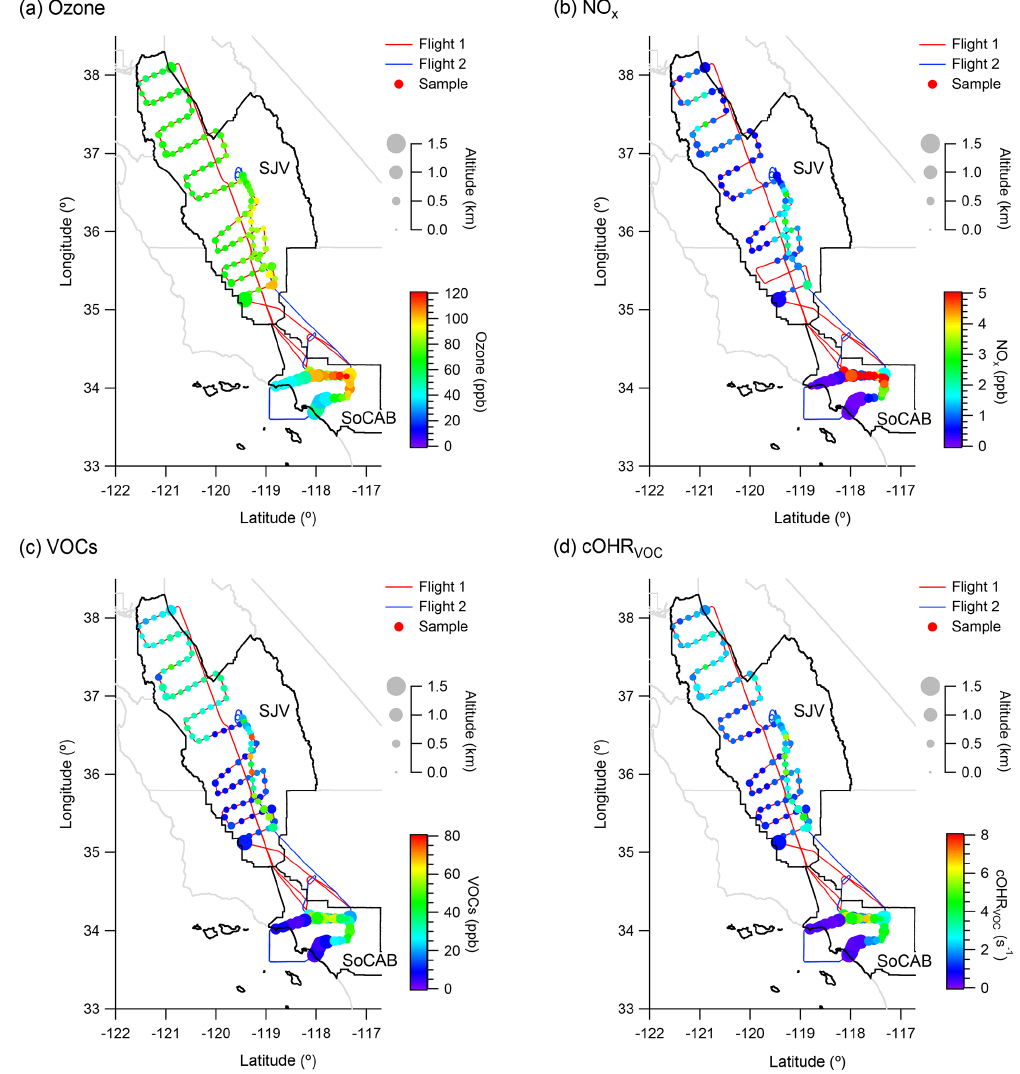
Figure 1. Spatial distribution of (a) O 3 , (b) NO x , (c) VOCs, and (d) cOHR VOC . The flight tracks and sample locations are represented by colored lines and points, respectively. The points are sized by flight altitude and colored by the mixing ratios of O 3 , NO x , VOCs, and cOHR VOC values in panels (a) , (b) , (c) , and (d) , respectively, with the scales shown in the legend. The background map (gray) shows the boundaries of the California air basins, with black indicating the SoCAB and